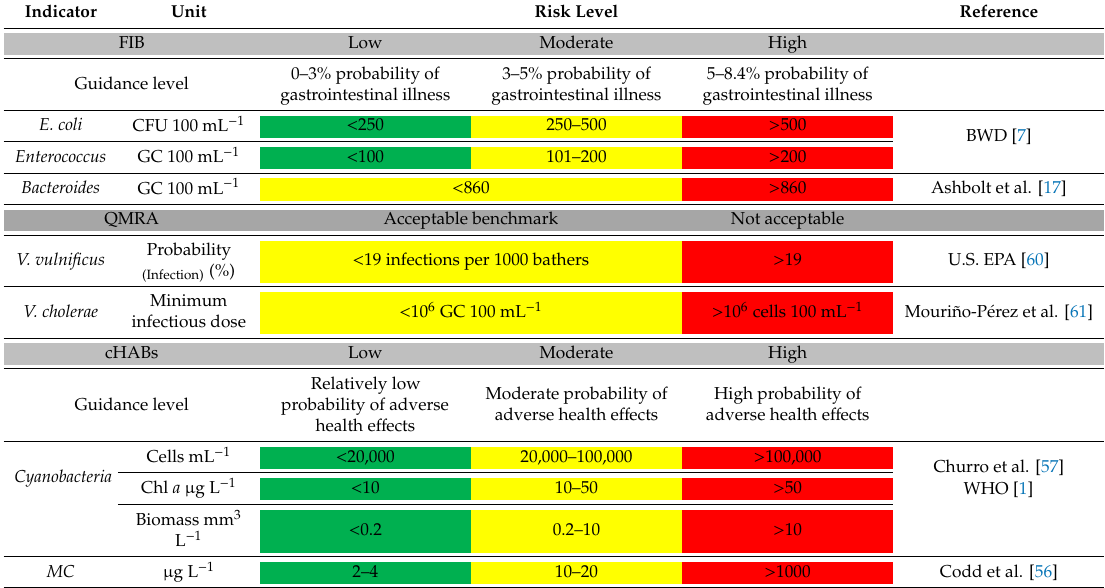
Table 2. Guideline values and thresholds of fecal indicator bacteria (FIB), V. cholerae , V. vulnificus , cyanobacteria, and microcystins (MCs) for integrated and safe practice in managing bathing waters. Indicator